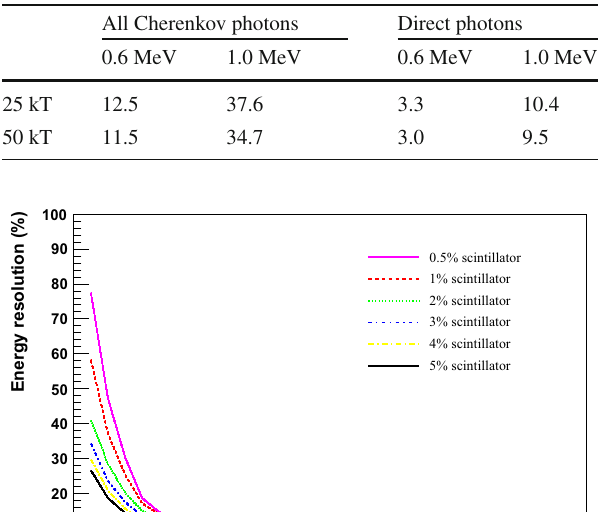
Table 1 Expected number of PMT hits from Cherenkov photons for a 90% PMT coverage detector. The first two columns include scattered photons and those absorbed and reemitted by wavelength shifter, while the second two columns include only photons that make it to the PMT directly without scattering or absorption. Results are shown across the range of energy thresholds considered for the analysis (Sect. 3). For comparison, assuming 1 kHz dark rates in the PMTs, we expect 1.2 PMT hits in the 25 kT detector and 1.9 hits in the 50 kT detector from